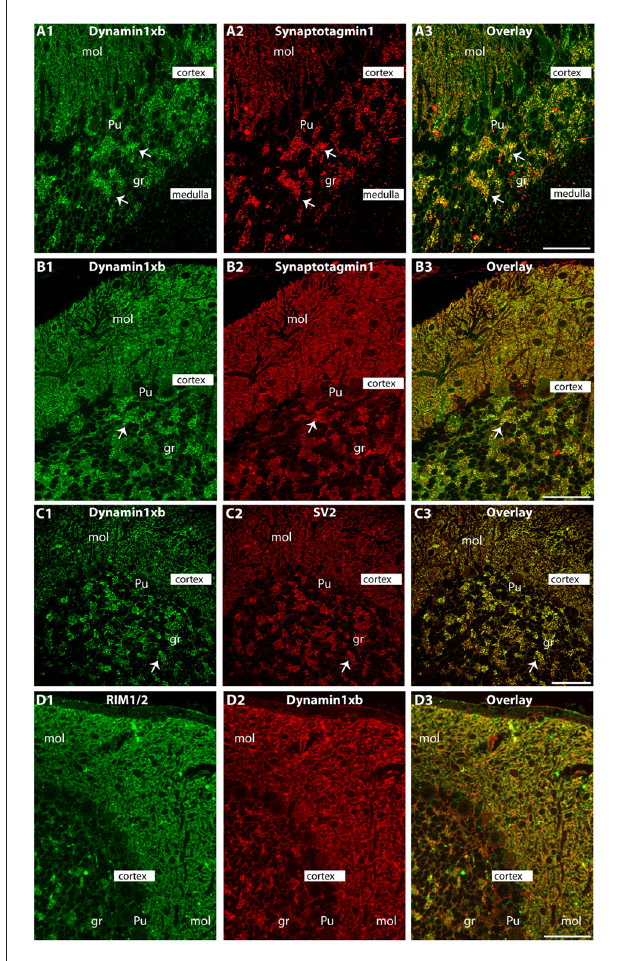
FIGURE 5 | Semi-thin (0.5 µ m-thin) sections of the mouse cerebellum double-immunolabeled with the monoclonal dynamin1xb antibody and the indicated other primary antibodies. The other primary antibodies against synaptotagmin1 (A,B) , synaptic vesicle protein 2 (SV2; C ) and RIM1/2 (D) were applied to label the synapses in order to better relate the dynamin1xb immunosignals to the synaptic regions. We observed a strong dynamin1xb immunosignal in the cerebellar cortex whereas the cerebellar medulla (white matter) that contains predominantly fiber tracts (but no synapses) was not immunolabeled. In the cerebellar cortex, dynamin1xb was highly enriched in the synaptic regions, i.e., the molecular layer (mol) of the cerebellar cortex and the giant synapses in the granule cell layer (arrows) of the cerebellar cortex. No significant dynamin1xb immunosignal was observed in the medulla of the cerebellum that predominantly contains axonal fiber tracts. (A,B,D) was obtained by epifluorescence microscopy; (C) was obtained by confocal microscopy. Abbreviations: mol, molecular layer; Pu, Purkinje cell layer; gr, granule cell layer. Scale bars: 50 µ m (A–D)